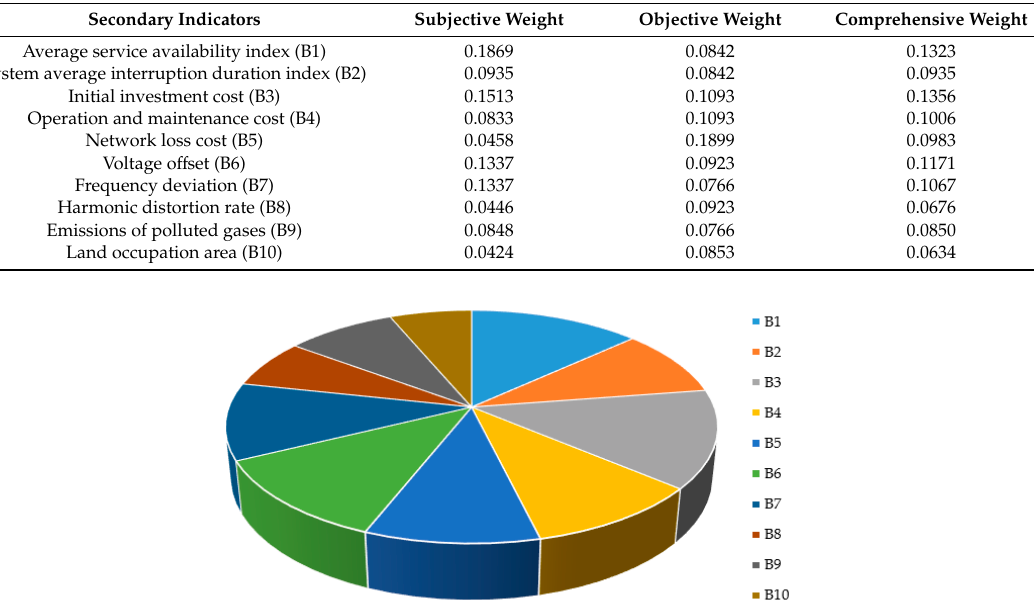
Table 7. Comprehensive weight.